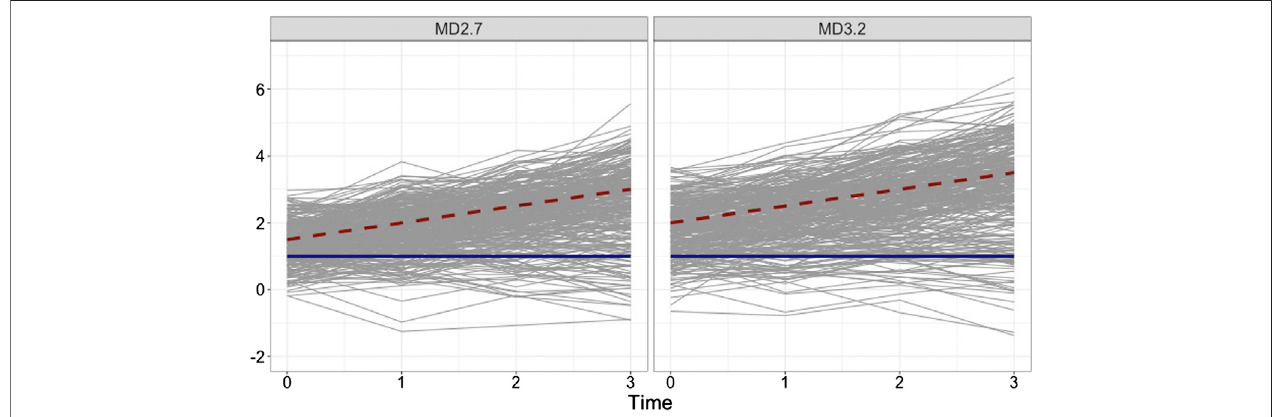
FIGURE 1 | Examples of simulated 300 individual growth trajectories from two groups that are relatively close to each other ( MD (cid:1) 2 . 7, left panel) and two groups that are relatively far away from each other ( MD (cid:1) 3 . 2, right panel). For each panel, the red dashed line indicates the growth trajectory for the fi rst class and the blue solid line indicates the growth trajectory for the second class.